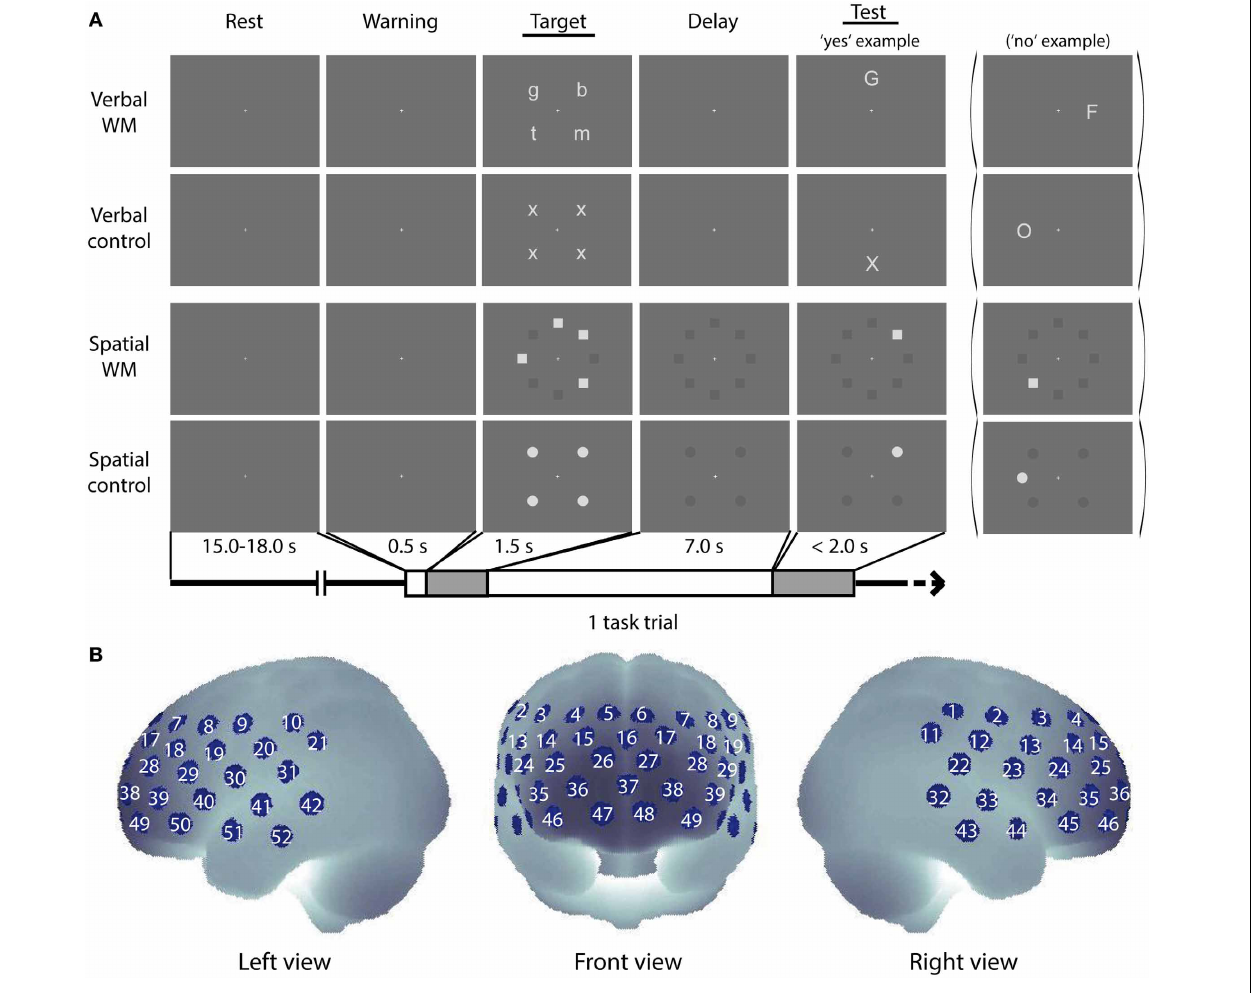
tasks for spatial WM are shown. (B) Arrangement of the NIRS measurement channels (52 measurement positions) in the Montreal Neurological Institute (MNI) space (see Materials and Methods, for more